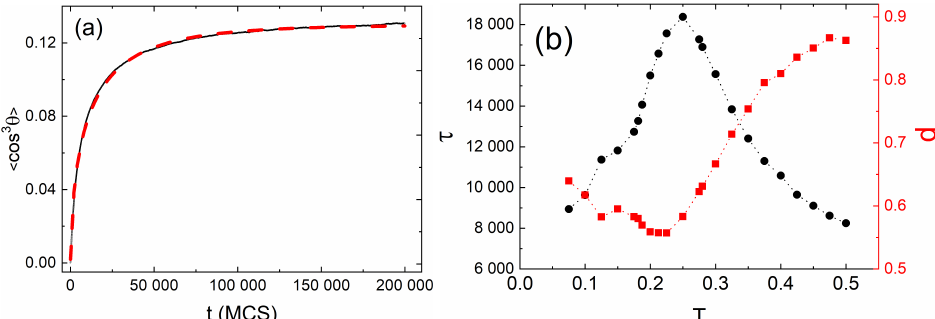
Figure 26. ( a ) MC-time dependence of acentric order parameter (cid:104) cos 3 θ (cid:105) ( t ) for T = 0.15 (solid black line). Dashed red line represents stretched exponential fit, Equation (51). ( b ) Temperature dependence of parameters of the fits: τ ( T ) (left axis) and d ( T ) (right